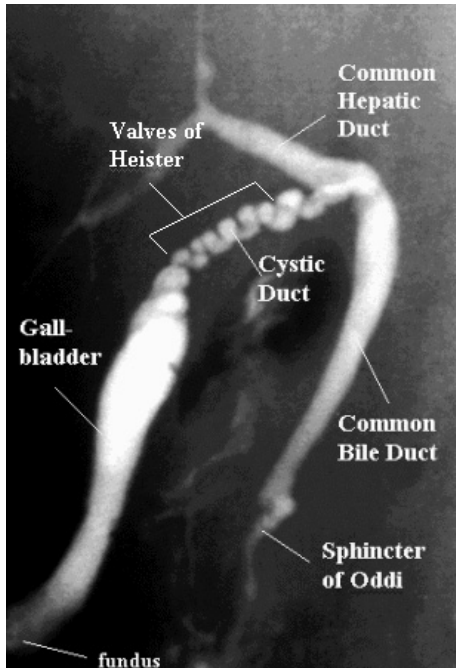
Fig. 1 Operative cholangiograms of a patient with gallstones (Image kindly provided by Department of Radiology, Royal Hallamshire Hospital,